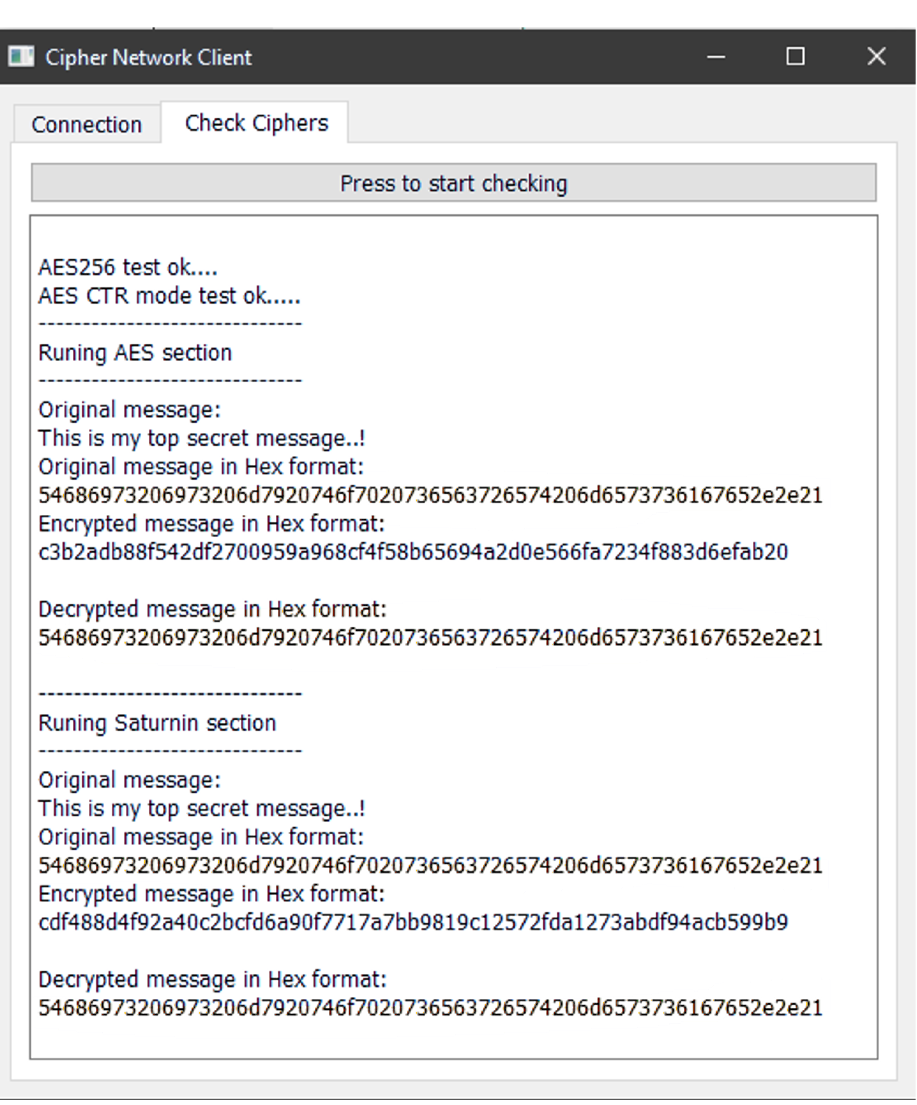
Figure 2. A screenshot from the execution of a setup, illustrating that, for both ciphers, the decrypted messages coincide with the original